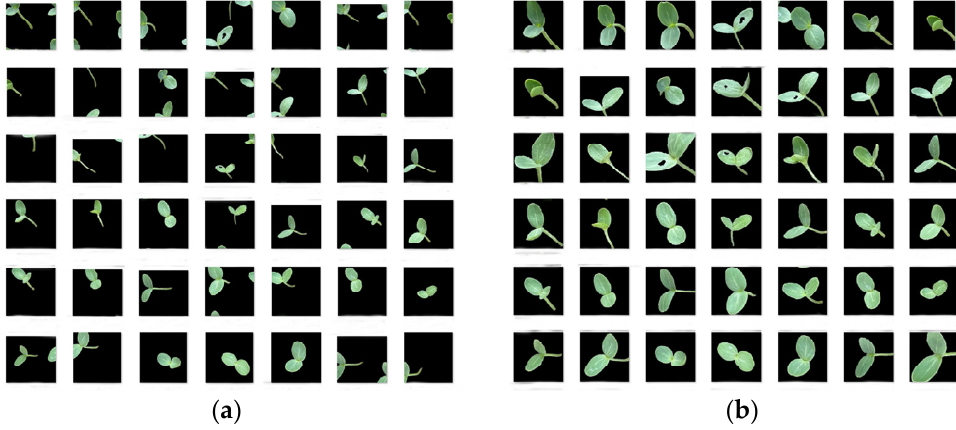
Figure 11. Skewed seedling correction before and after effect. ( a ) Image before correction of the skewed seedling. ( b ) Image after correction of the skewed seedling.